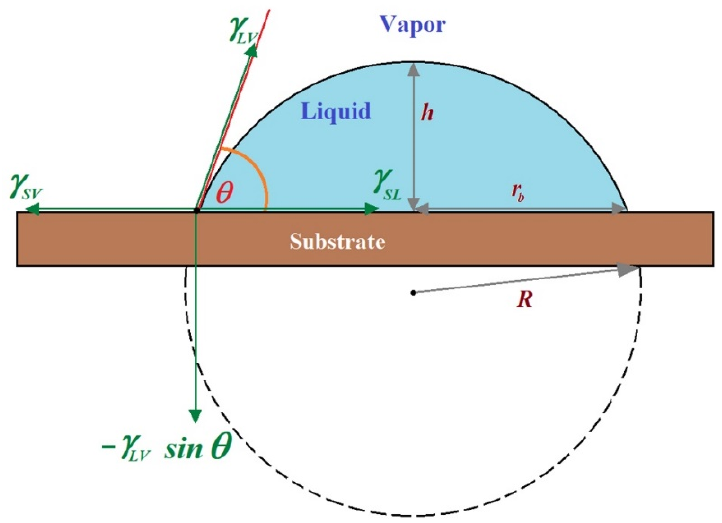
Figure 1. Definition of contact angle ( θ ) and other parameters: h (height), r b (base radius), R (radius of the sphere) of a spherical droplet on a substrate. γ SV (solid–vapor interfacial tension), γ LV (liquid– vapor interfacial tension) and γ SL (solid–liquid interfacial tension).